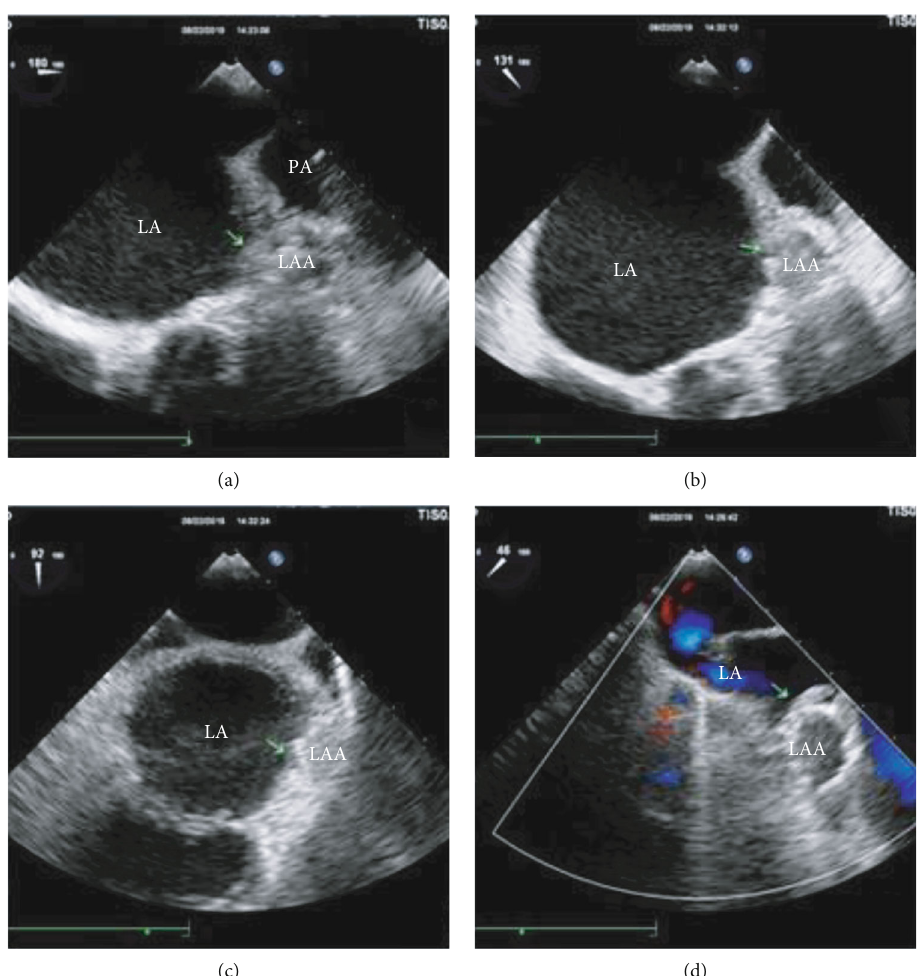
Figure 3: Transesophageal echocardiography (TEE) images after the operation. TEE showed the left atrial appendage from four di ff erent angles (the green arrow points to the ostium of the left atrial